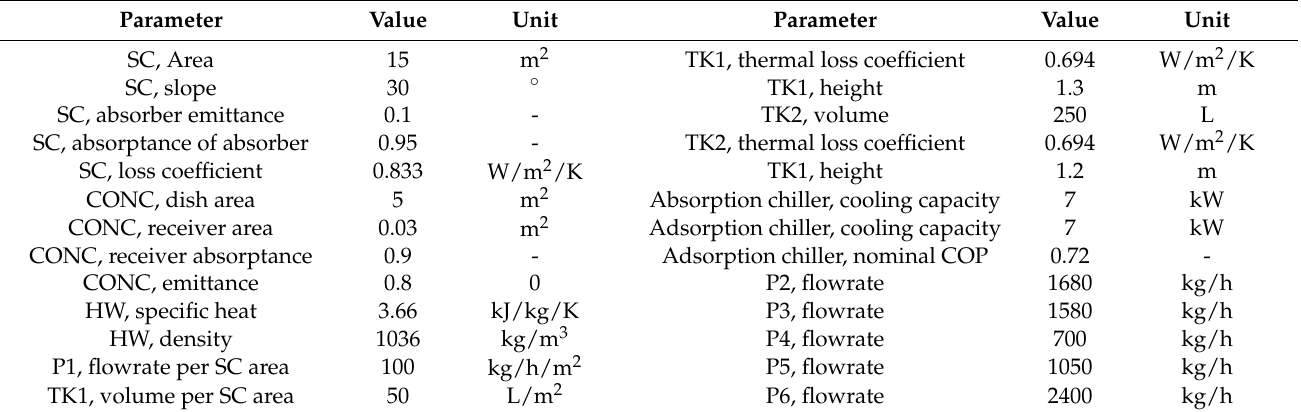
Table 4. Parameters of the main components of the hybrid system.